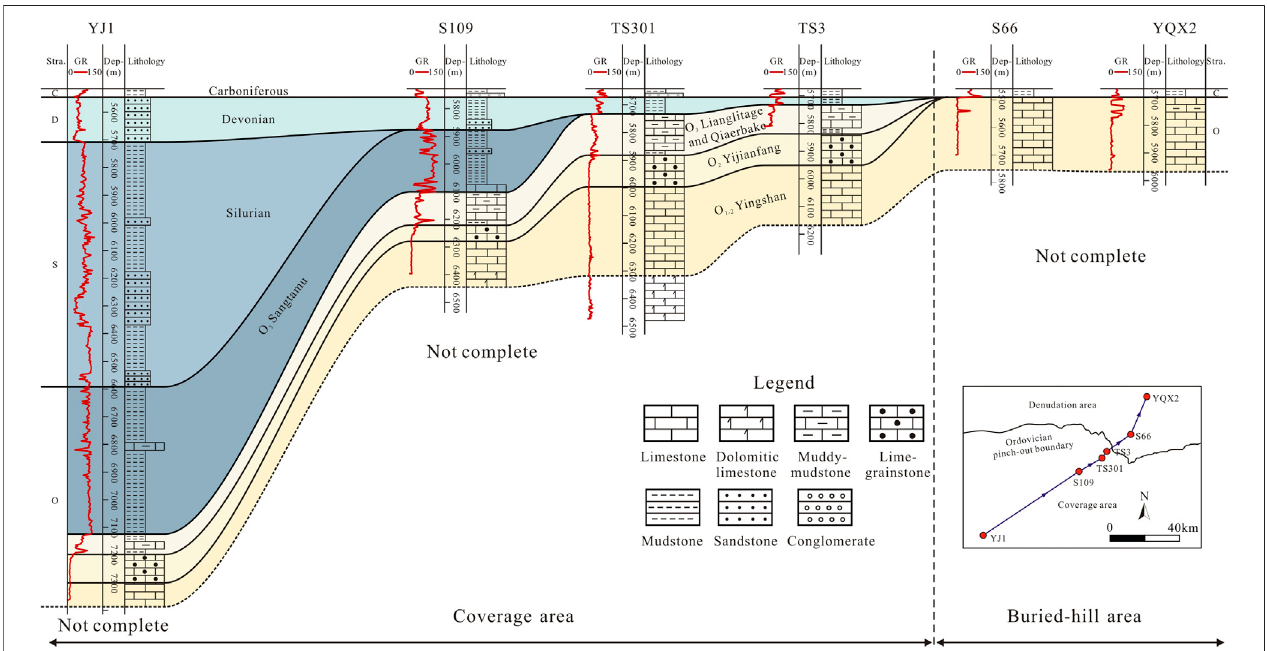
FIGURE 2 | Cross section of the Tahe area shows different formation contacts in the south to north.